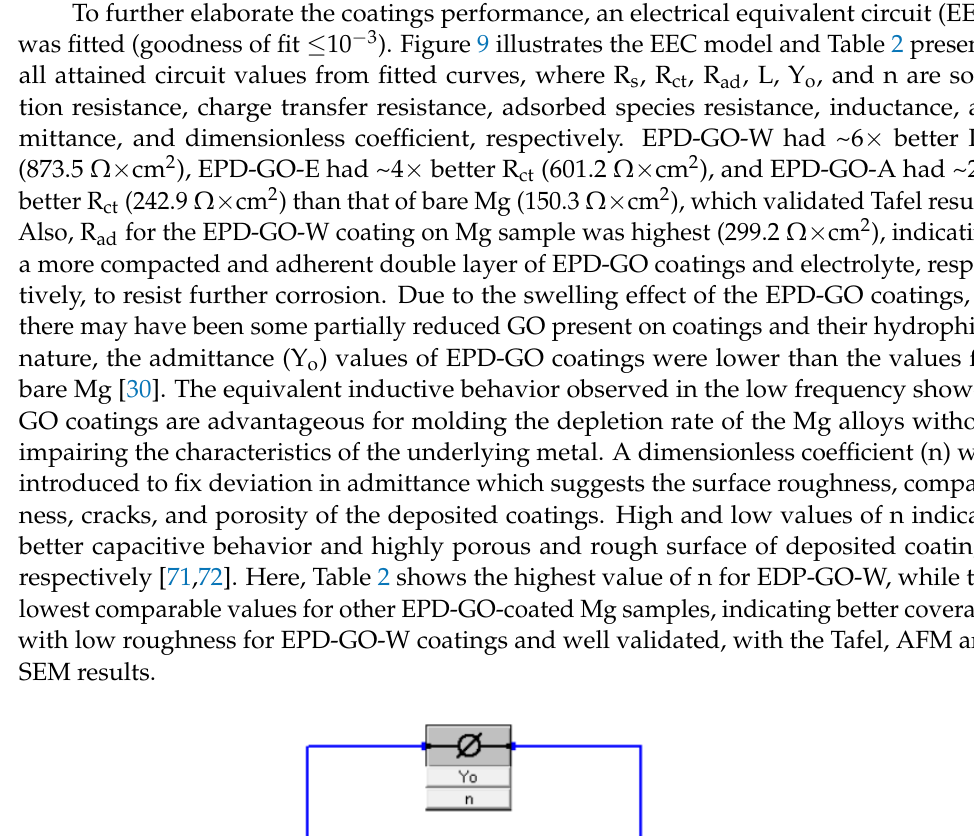
Figure 8. Fitted ( a ) Nyquist and ( b ) bode plot of uncoated and EPD-GO-coated Mg samples.